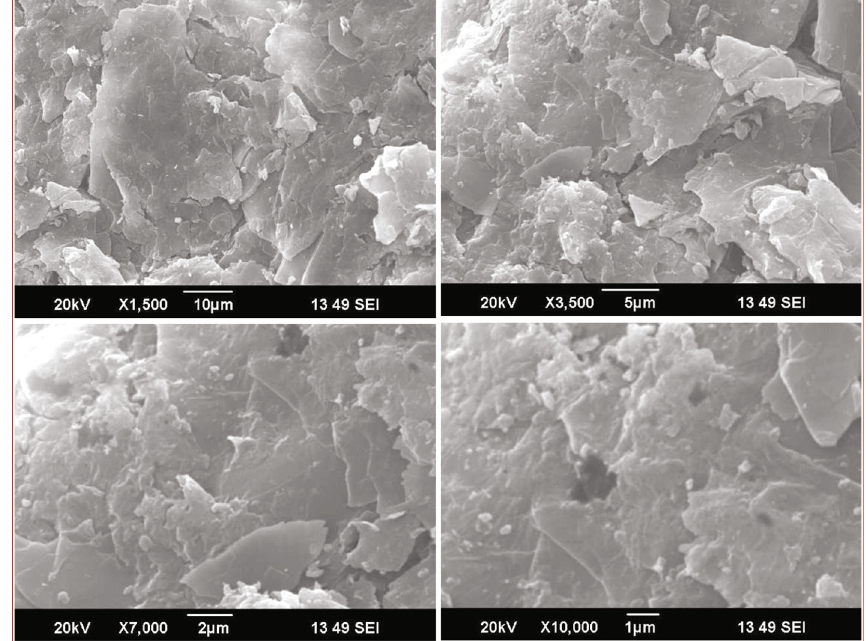
Figure 4: SEM image of as synthesized GFT nanocomposite with di ff erent magni fi